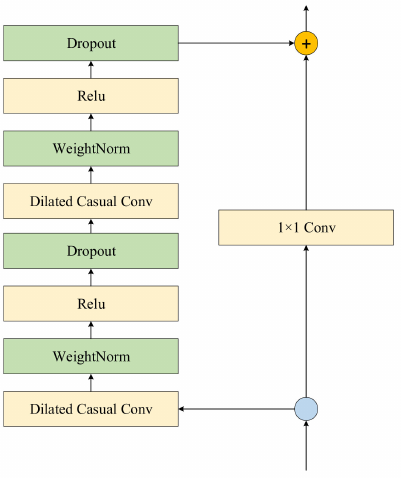
Figure 4. Residual